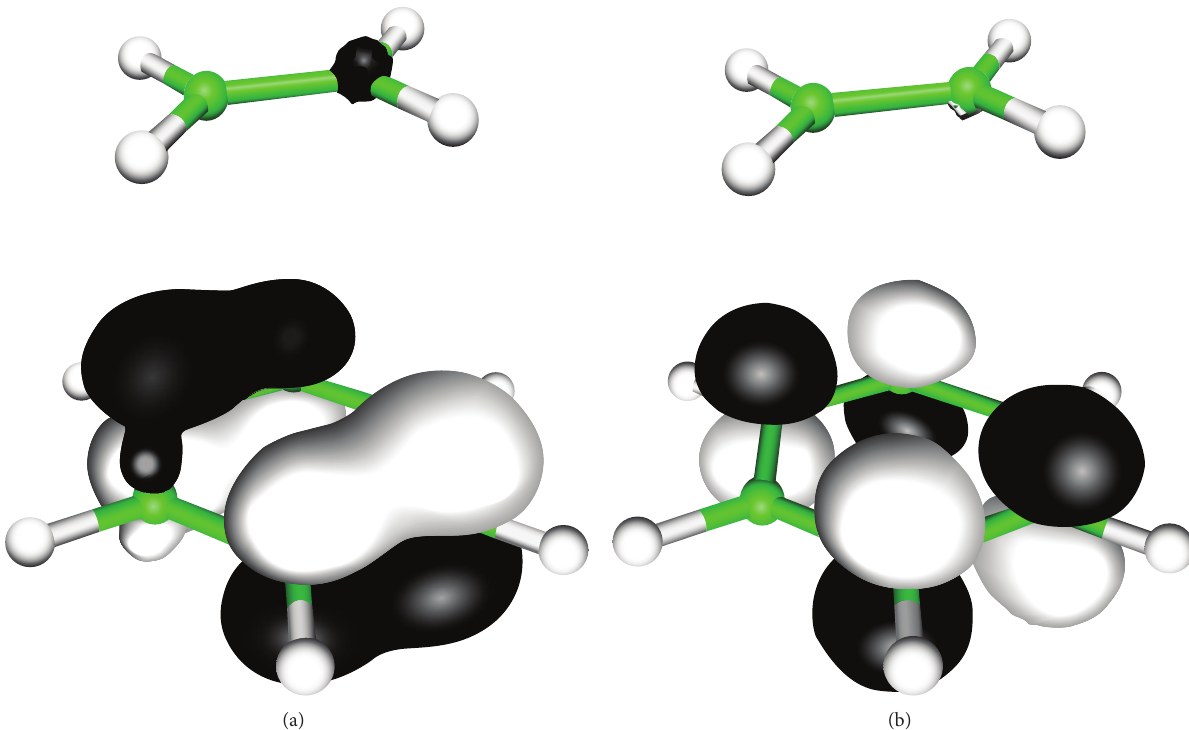
Figure 4: The diagrams for the HOMO and LUMO of benzene and ethylene molecules at the equilibrated structure computed by the DFTB